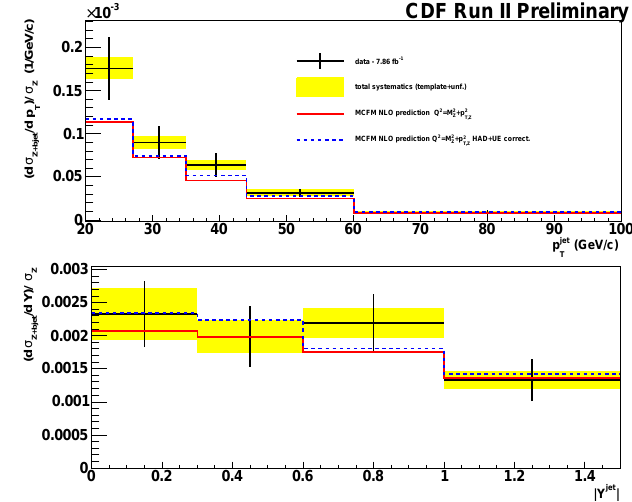
Fig. 5. Measurement of the inclusive production cross sections of Z + ( n )jets for n = 1 predictions from B lackhat+ S herpa and also presented as a ratio of data / theory in comparison with A lpgen+ P ythia predictions and LO / NLO pQCD predictions from mcfm for a variety of choices of scale and parton density functions.